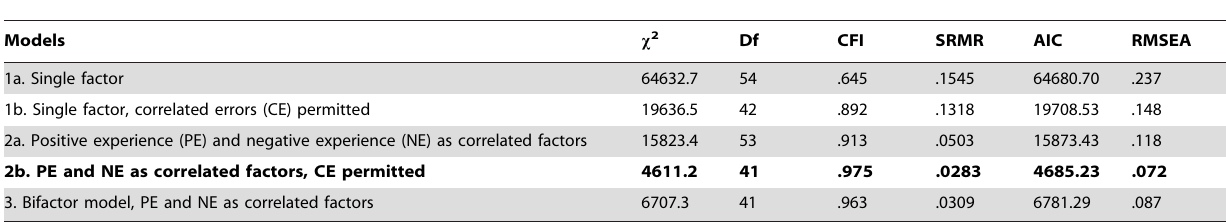
Table 3. Fit indices for CFA models of the SPANE (best fitting model in bold).